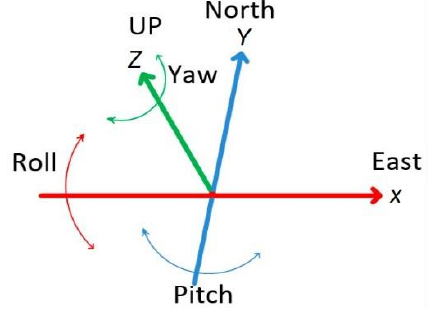
Figure 5. Roll, pitch, yaw (RPY) system reference.